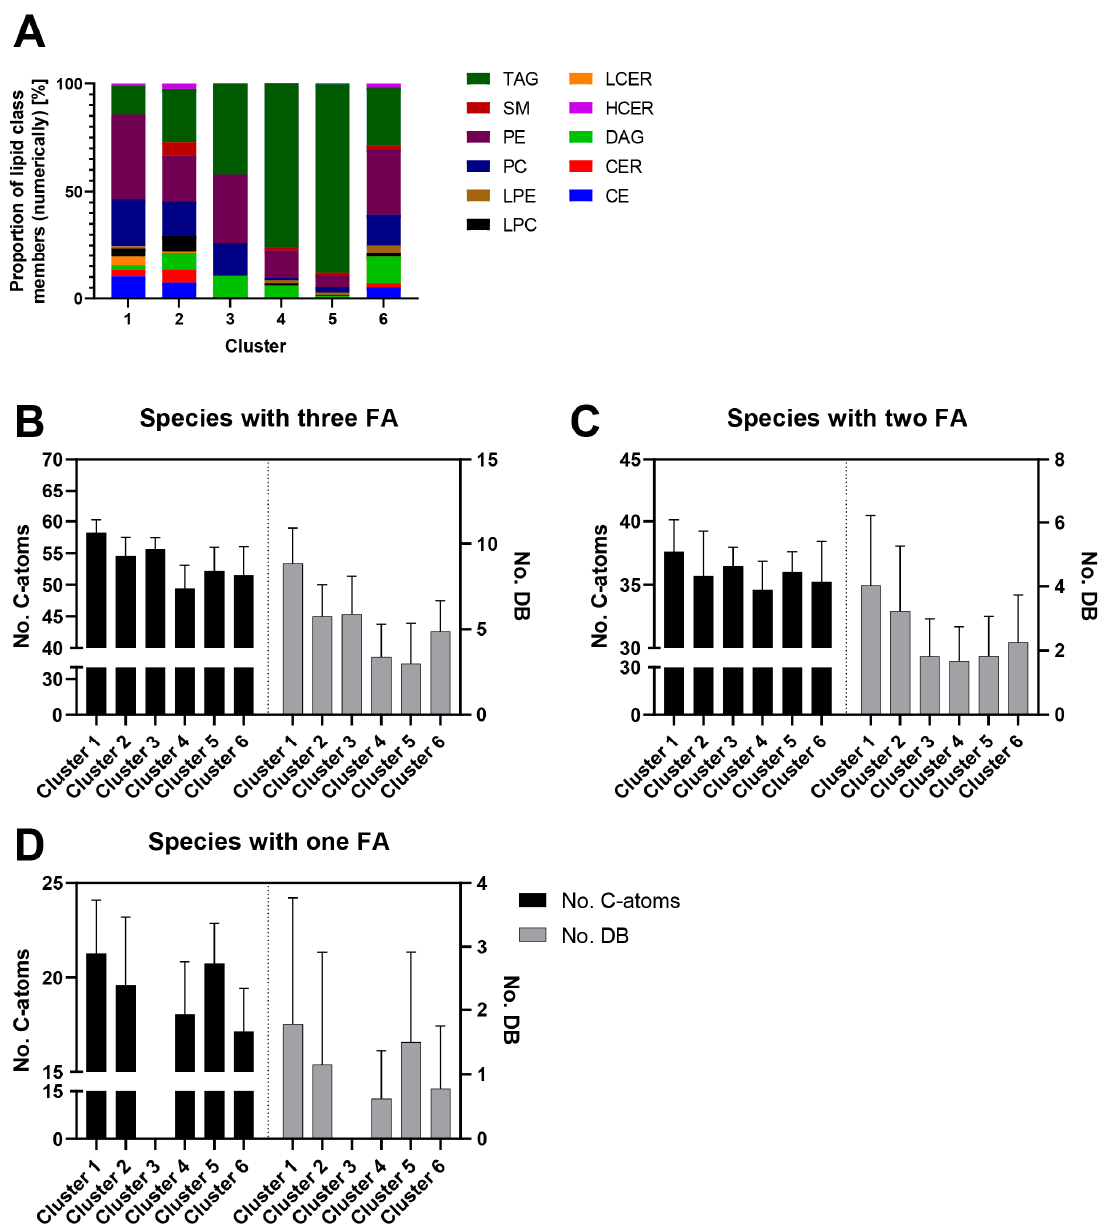
Figure 6. Clusters differed widely in their lipid class and lipid species composition. Panel A highlights the cluster compositions by showing the relative numerical proportions of the lipid class members. Panels B–D show the analysis of the FA side chain lengths and the number of DB based on the number of side chains of the lipid classes. Panel B shows the analysis of the class with three bound FA side chains, panel C that of lipid classes with two bound FA side chains, and panel D that of classes with only one FA side chain. Lipid species with patterns of decreasing concentration throughout adipogenesis had in general the highest numbers of DB and chain lengths, independent of their number of side chains.